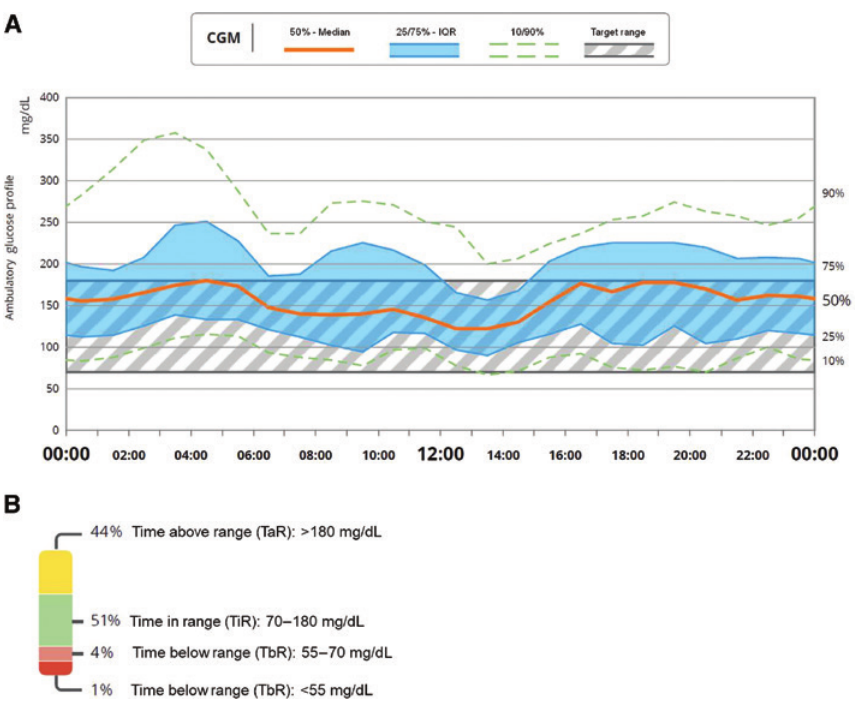
Figure 2: Dexcom CLARITY ® software. (A) Ambulatory glucose profile (AGP) generated and modified from Dexcom CLARITY ® software; (B) graph represents an exemplary overview of the percentage of time spent in specific ranges (generated and modified from Dexcom CLARITY ®